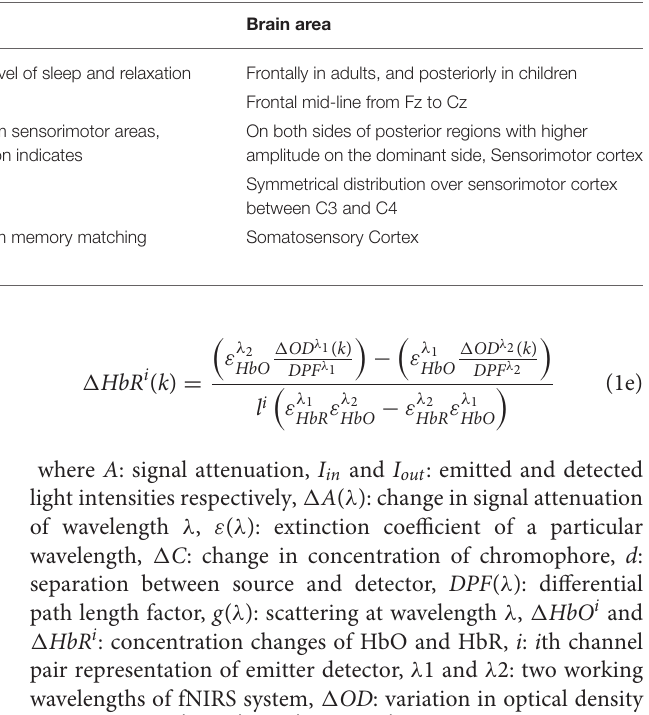
hundreds of megahertz) of incident light (Boas et al.,